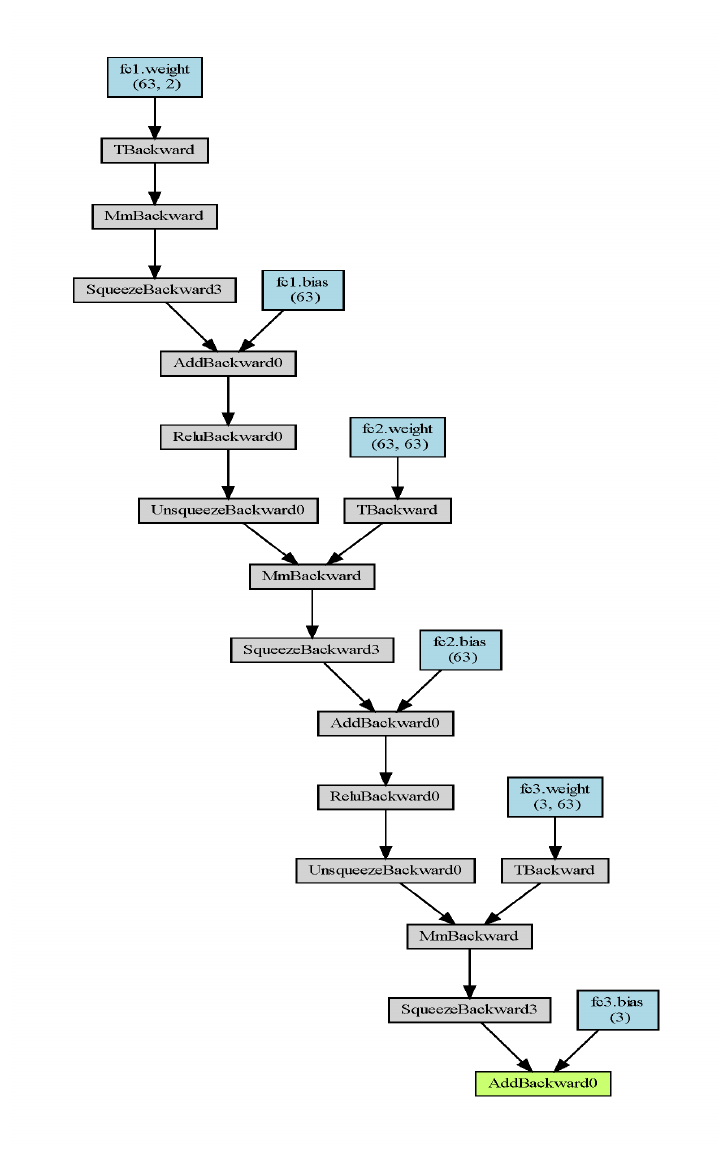
Figure 3. The network structure we used in the